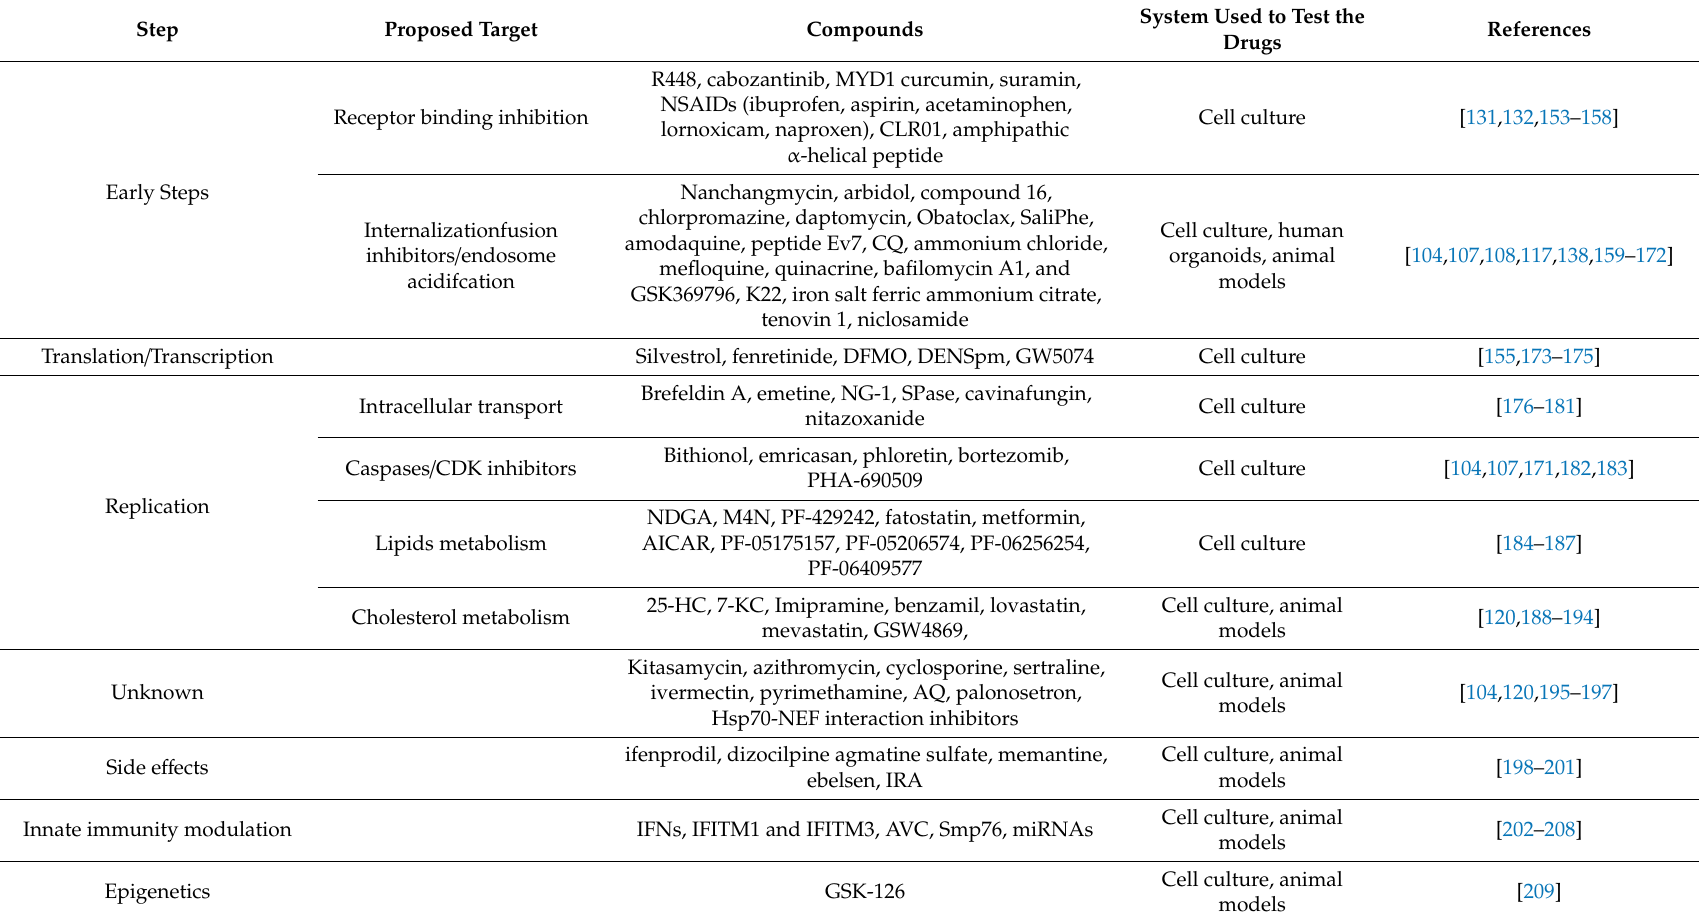
Table 3. Host acting antivirals (HAAs) against